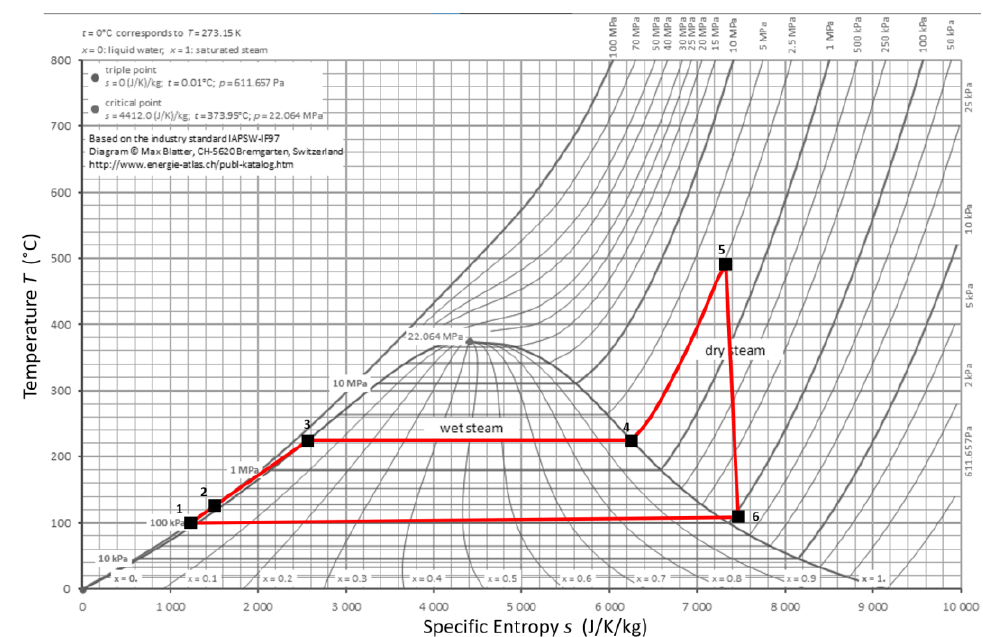
Figure 5. T-s diagram for the actual steam turbine cycle of the designed system.